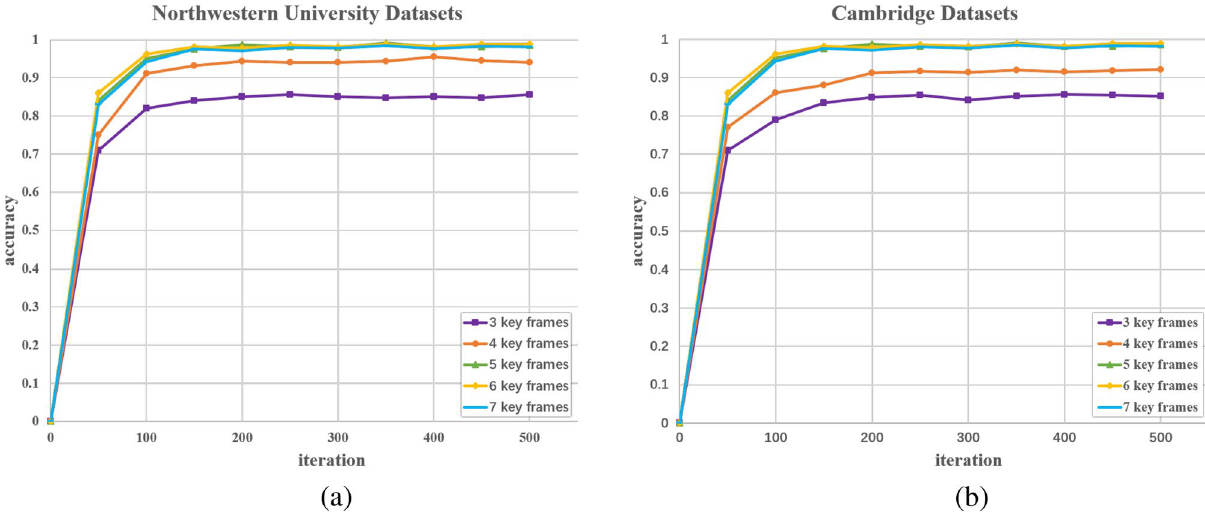
Figure 11. Accuracy curve. ( a ) Northwestern University datasets, ( b ) Cambridge datasets.